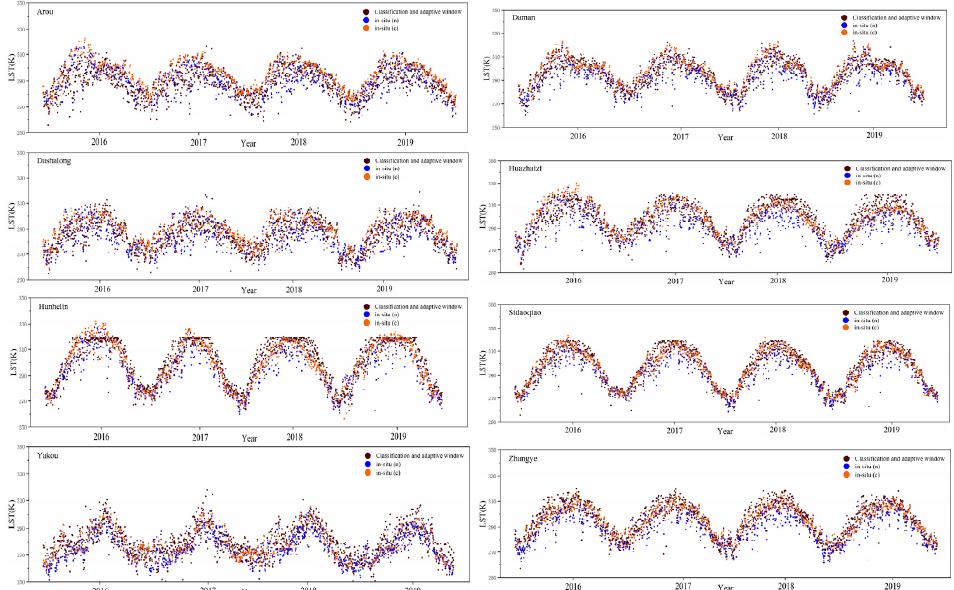
Figure 7. Comparison of reconstructed LST using classification and adaptive window with LST measured by AWS at 8 sites from 2016 to 2019. in situ (n) indicates the measured LST with cloudy skies at the observation station; in situ (c) indicates the measured LST with clear skies at the observation station.